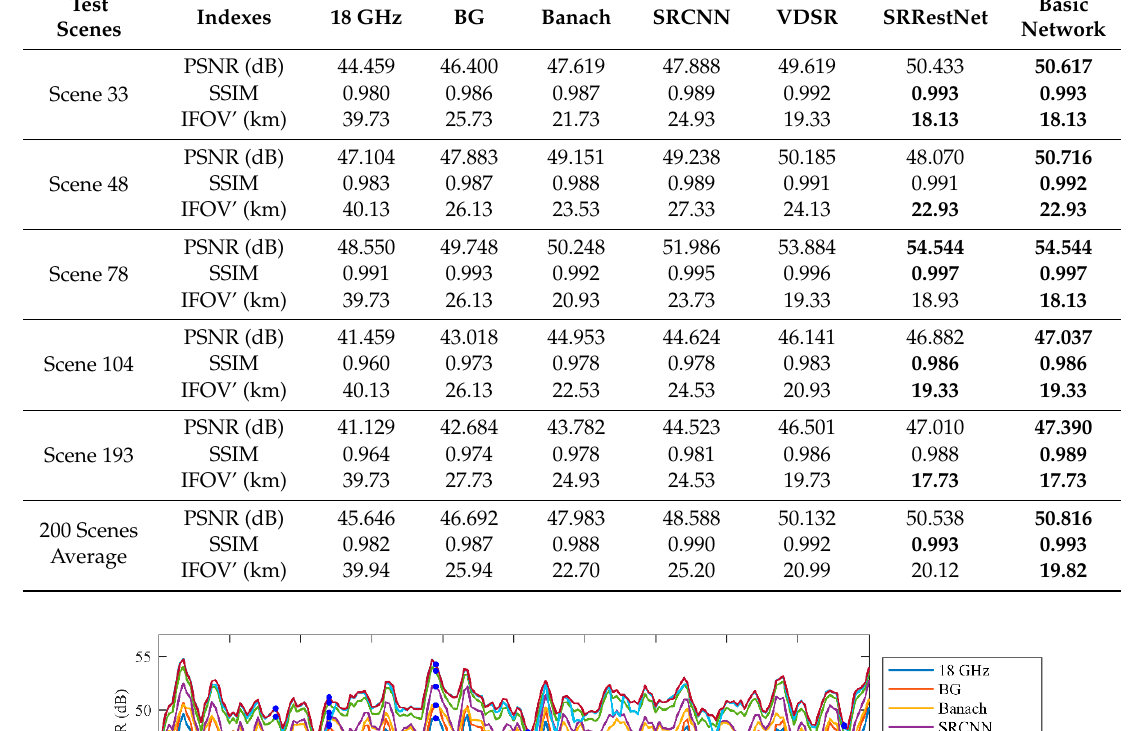
Table 3. The evaluation indexes of the test set.